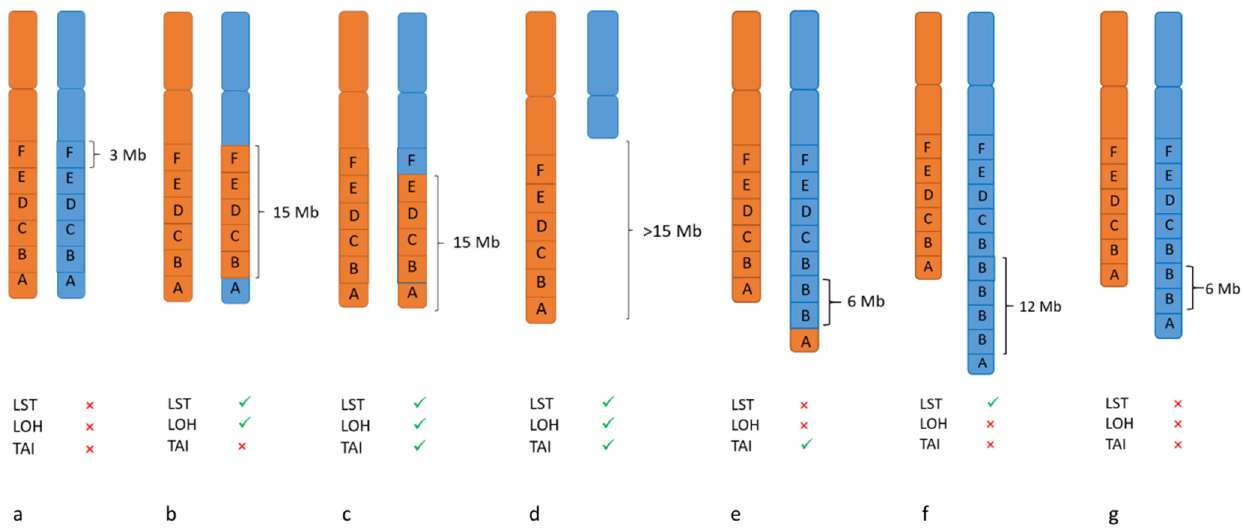
Figure 2. Examples for different alterations which lead to genomic scars. ( a ) Normal chromosomal pattern with maternal and paternal alleles (A–F); each box represents 3 Mb. ( b – g ) Alterations like rearrangements, loss or gain of chromosomal material that can result in positive scores for LOH (loss of heterozygosity), LST (large scale state transitions) and TAI (telomeric allelic imbalance).